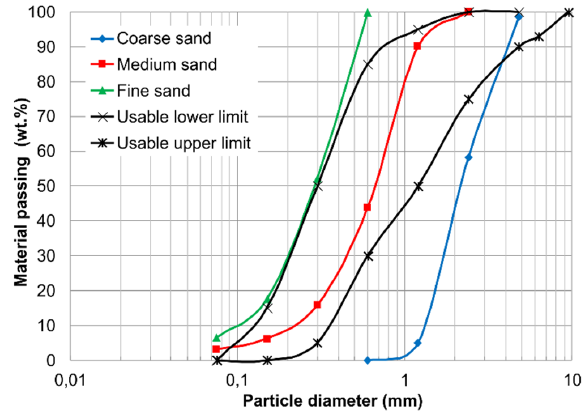
Figure 2. Cumulative underflow distribution of different CDW granulometries and normal upper and lower limits for concrete production.